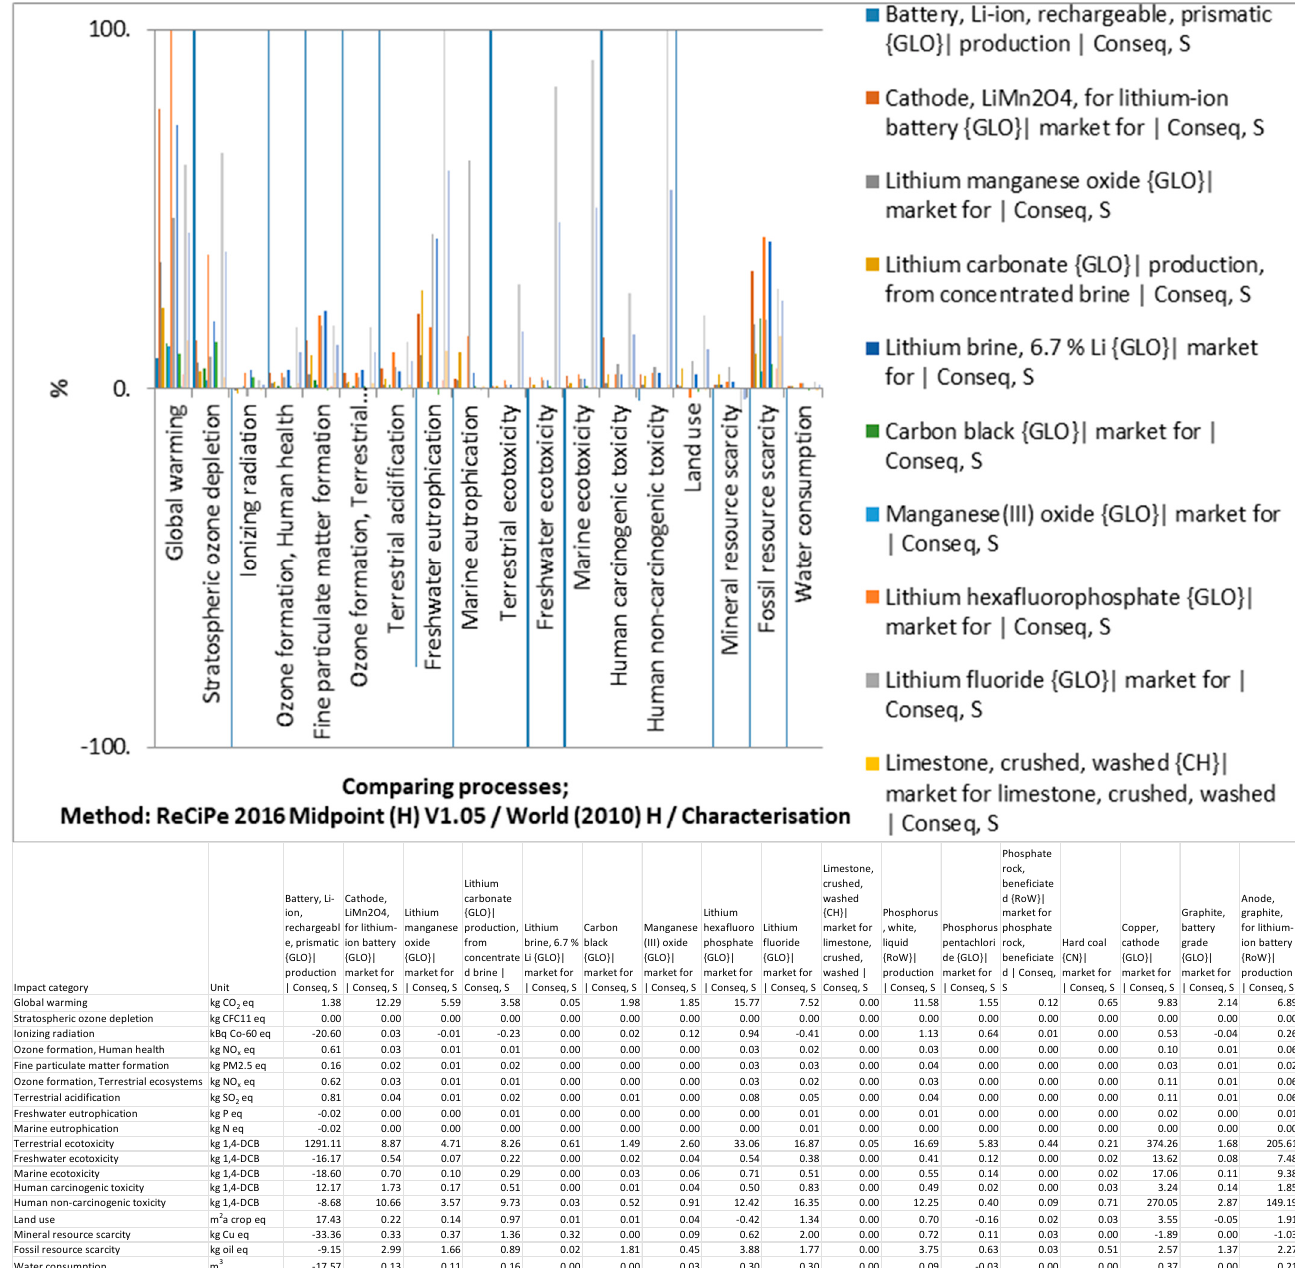
Impact category